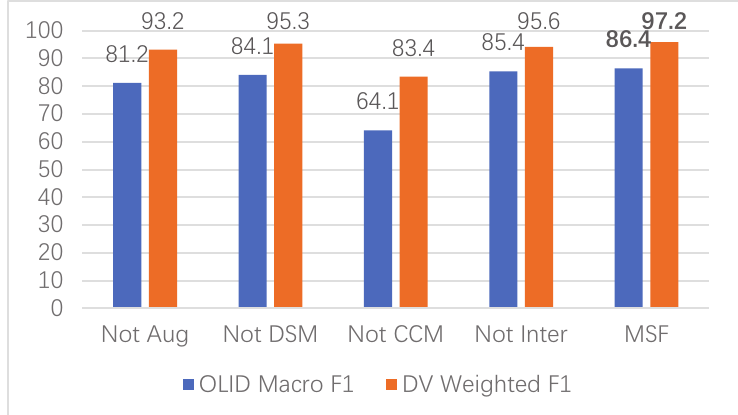
Figure 2. The results of ablation